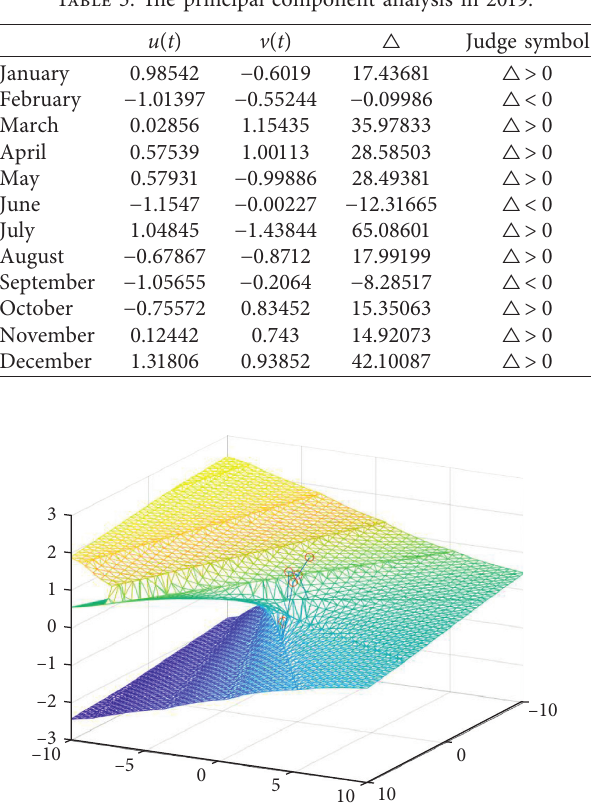
Figure 6: Three-dimensional renderings of sudden changes in Shanghai crude oil futures prices in 2019.